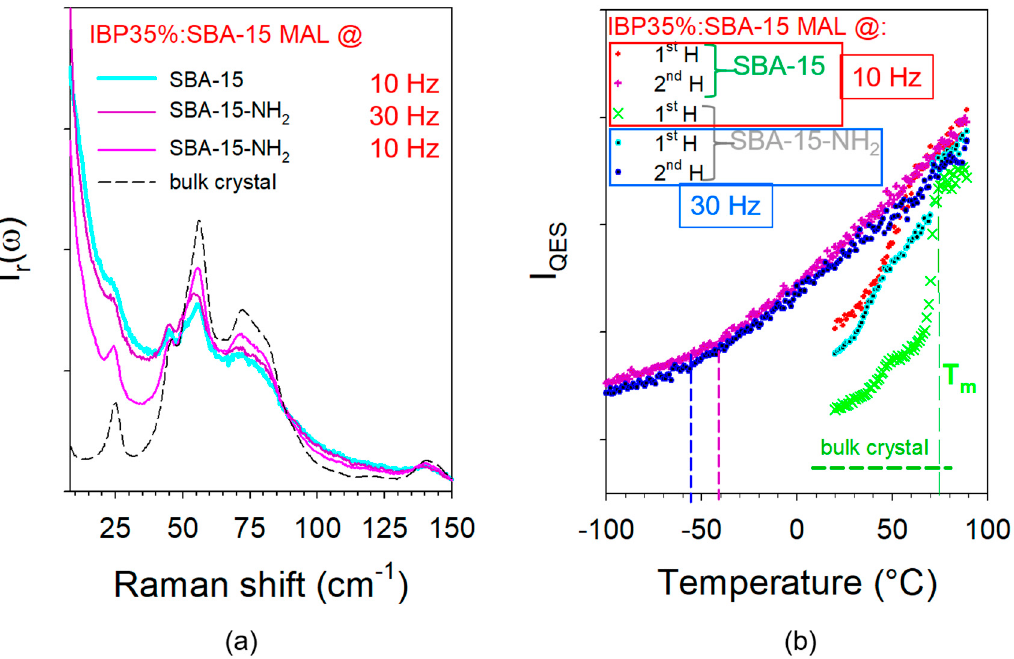
Figure 7. Low-frequency analysis of composites prepared with as-received (SBA-15) and modified (SBA-15-NH 2 ) matrices by MAL at various frequencies; ( a ) spectra of freshly prepared composites taken at room temperature compared with the spectrum of the commercial phase; ( b ) temperature dependence of the quasielastic intensity (I QES ) obtained upon a first heating from room temperature and a second successive heating; vertical dashed lines roughly indicate T g .